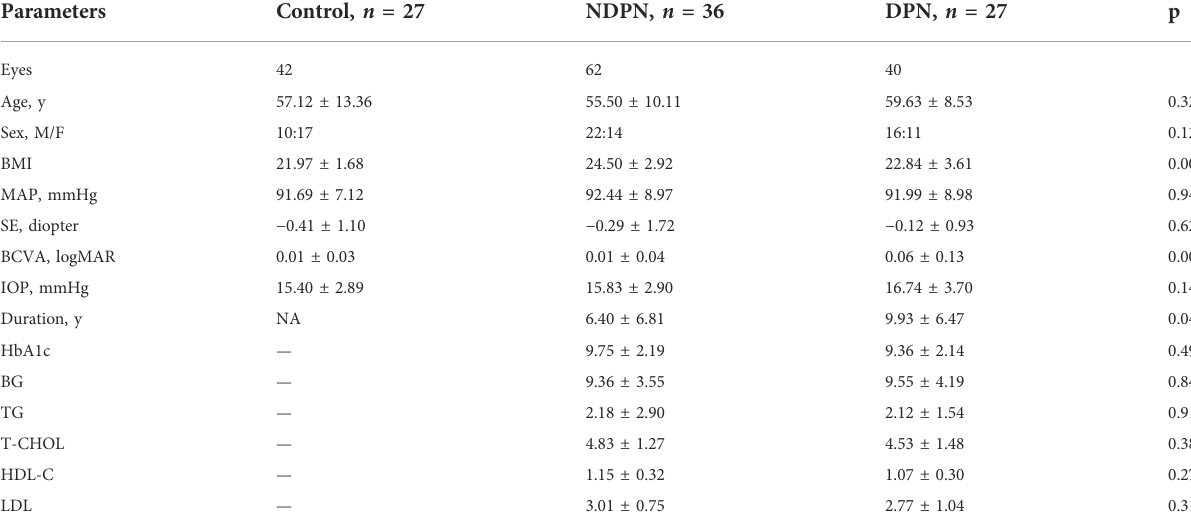
TABLE 1 Demographic characteristics of all